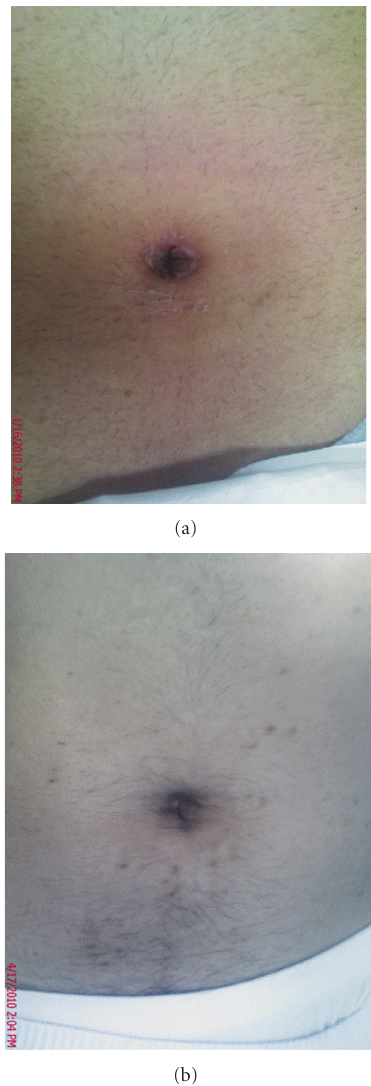
Figure 3: Views of umbilical scar after